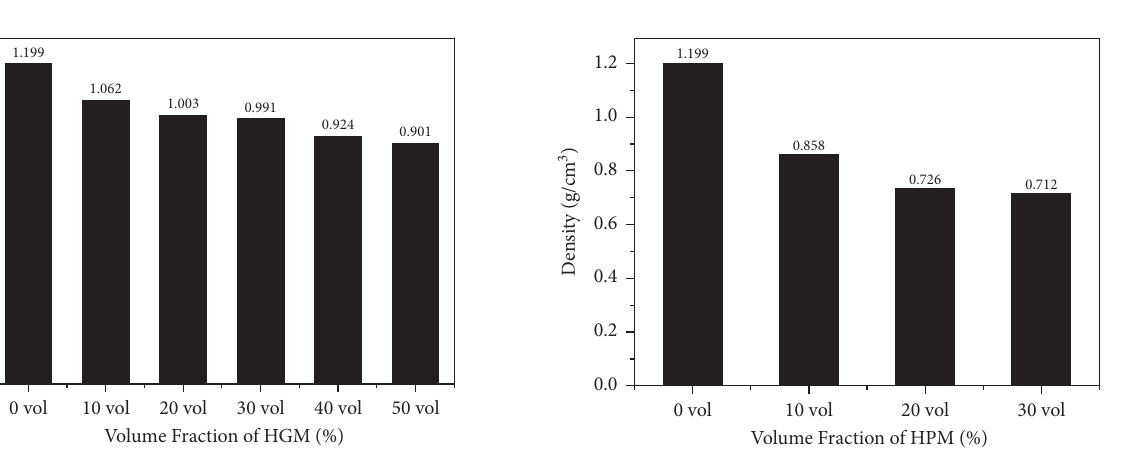
Figure 3: The density of HGM/phenolic syntactic foam. Figure 4: The density of HPM/phenolic syntactic foam.